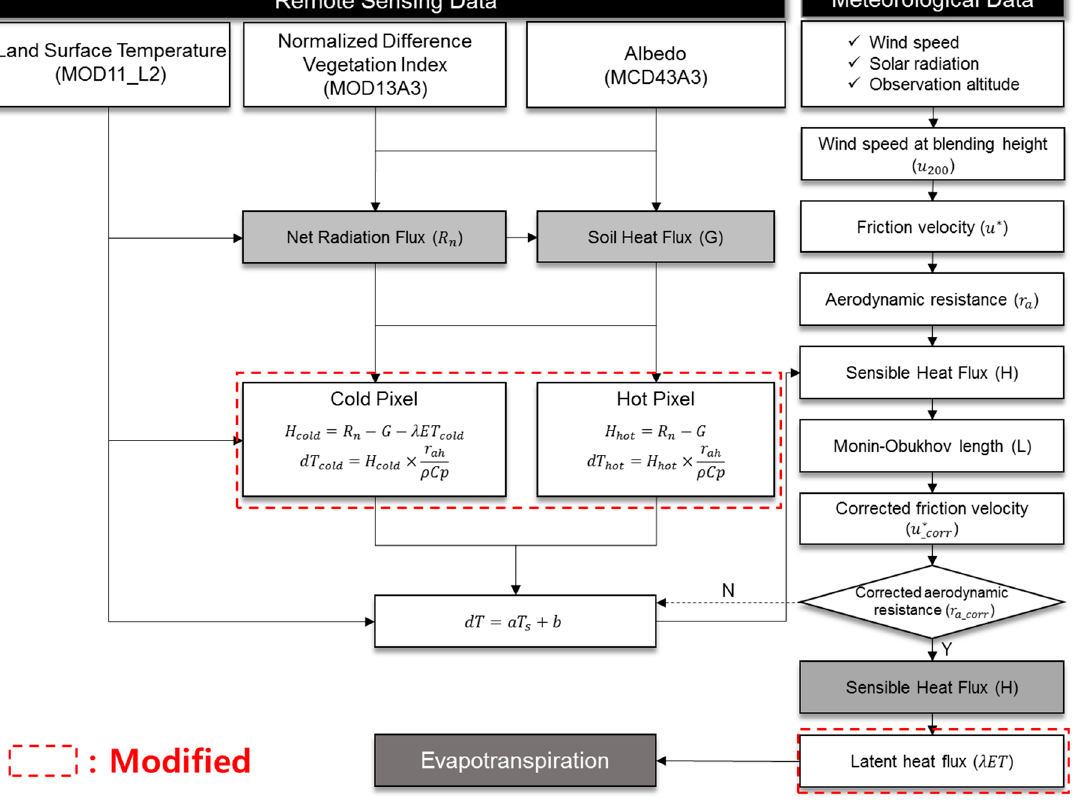
Figure 1. Flowchart of the Surface Energy Balance Algorithm for Land (SEBAL) model.